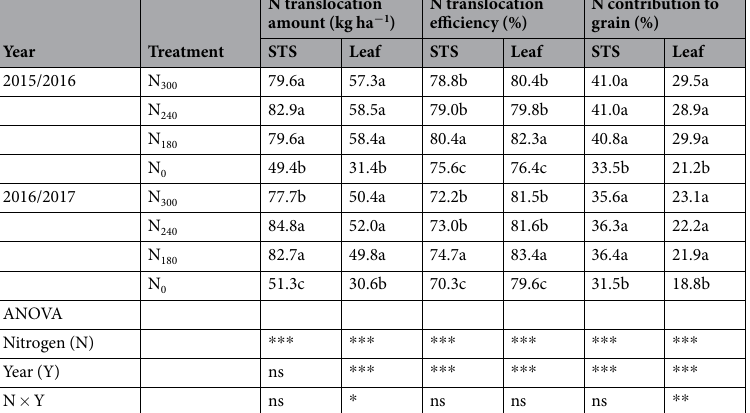
** Table 2. N translocation of vegetable organs in wheat and its contribution to grain from anthesis to maturity under different N treatments in 2015/2016 and 2016/2017. N 300 , N 240 , N 180 and N 0 represent N application rate at 300, 240, 180 and 0 kg N ha − 1 , respectively. STS, Stem and sheath. Different letters indicate statistical significance at P < 0.05 among treatments. * Significant at P < 0.05. ** Significant at P < 0.01. *** Significant at P < 0.001. ns, not significant, P ≥